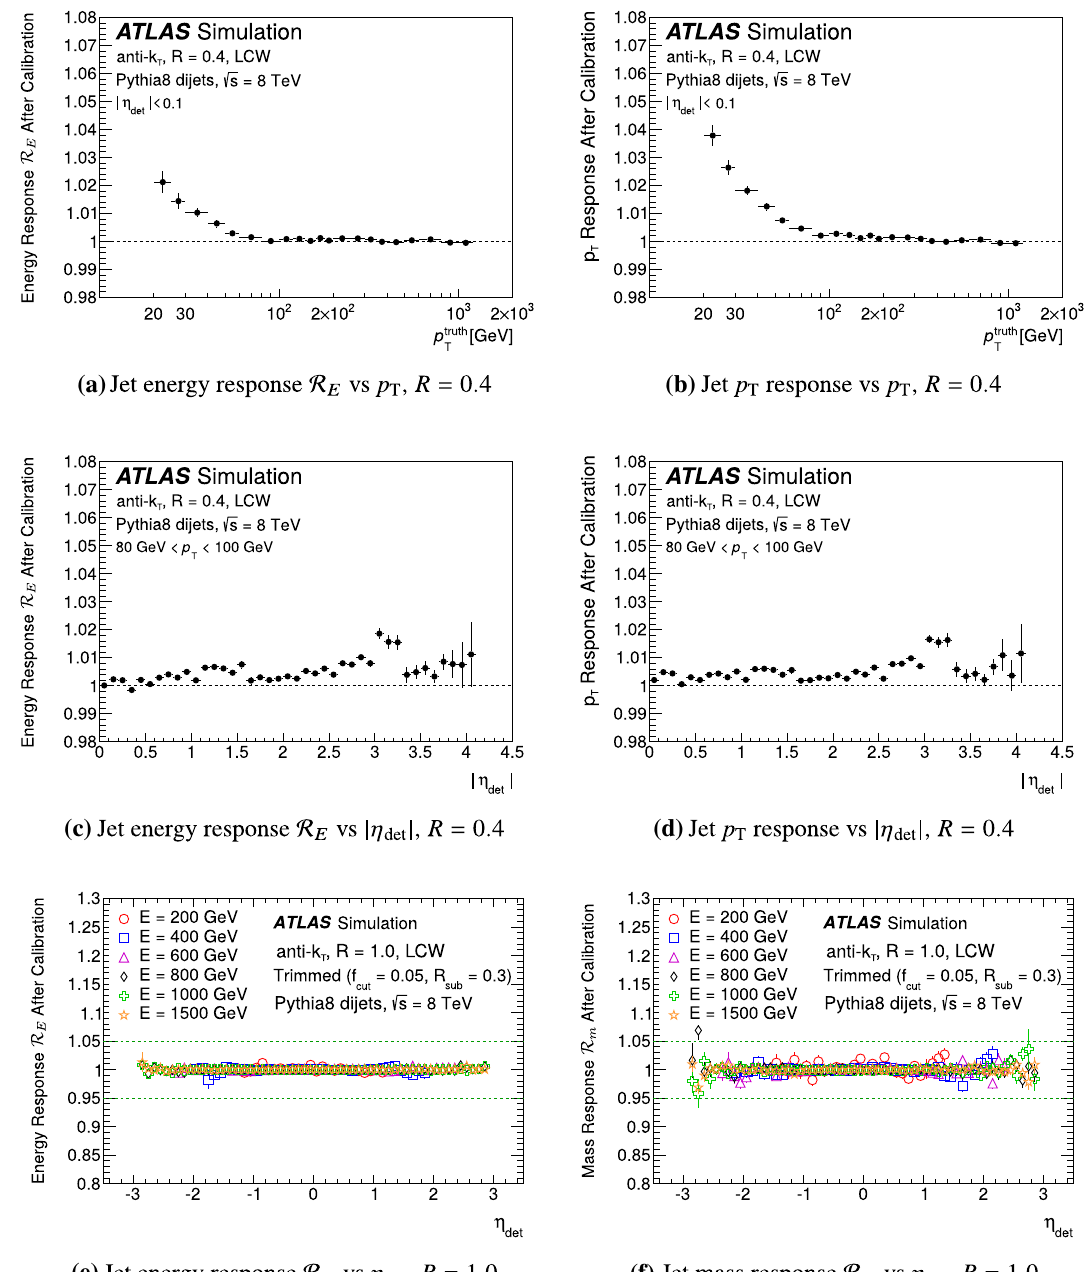
Fig. 5 Jet energy, p T , and mass response after the MC-based jet calibration has been applied for R = 0 . 4 and R = 1 . 0 anti- k t jets reconstructed from LCW calibrated topo-clusters